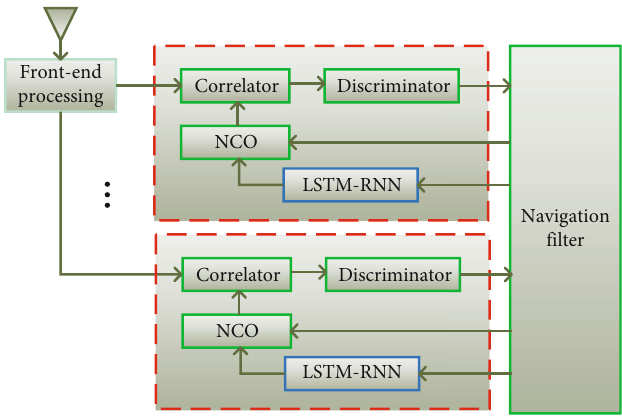
Figure 6: LSTM-RNN-assisted